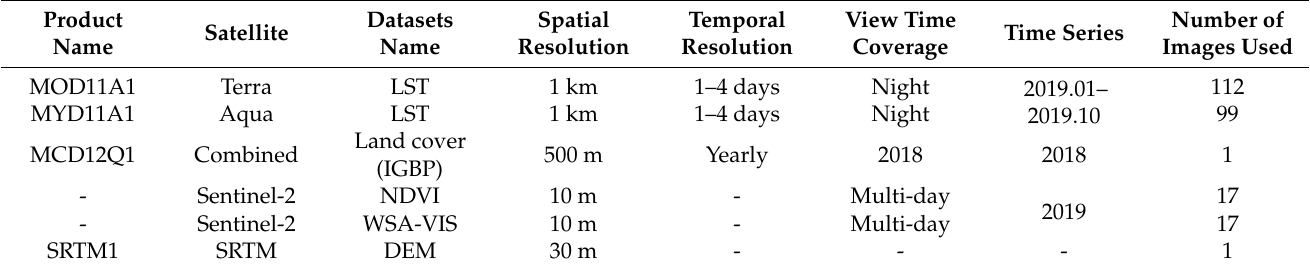
Table 1. MODIS datasets and ancillaries used in this